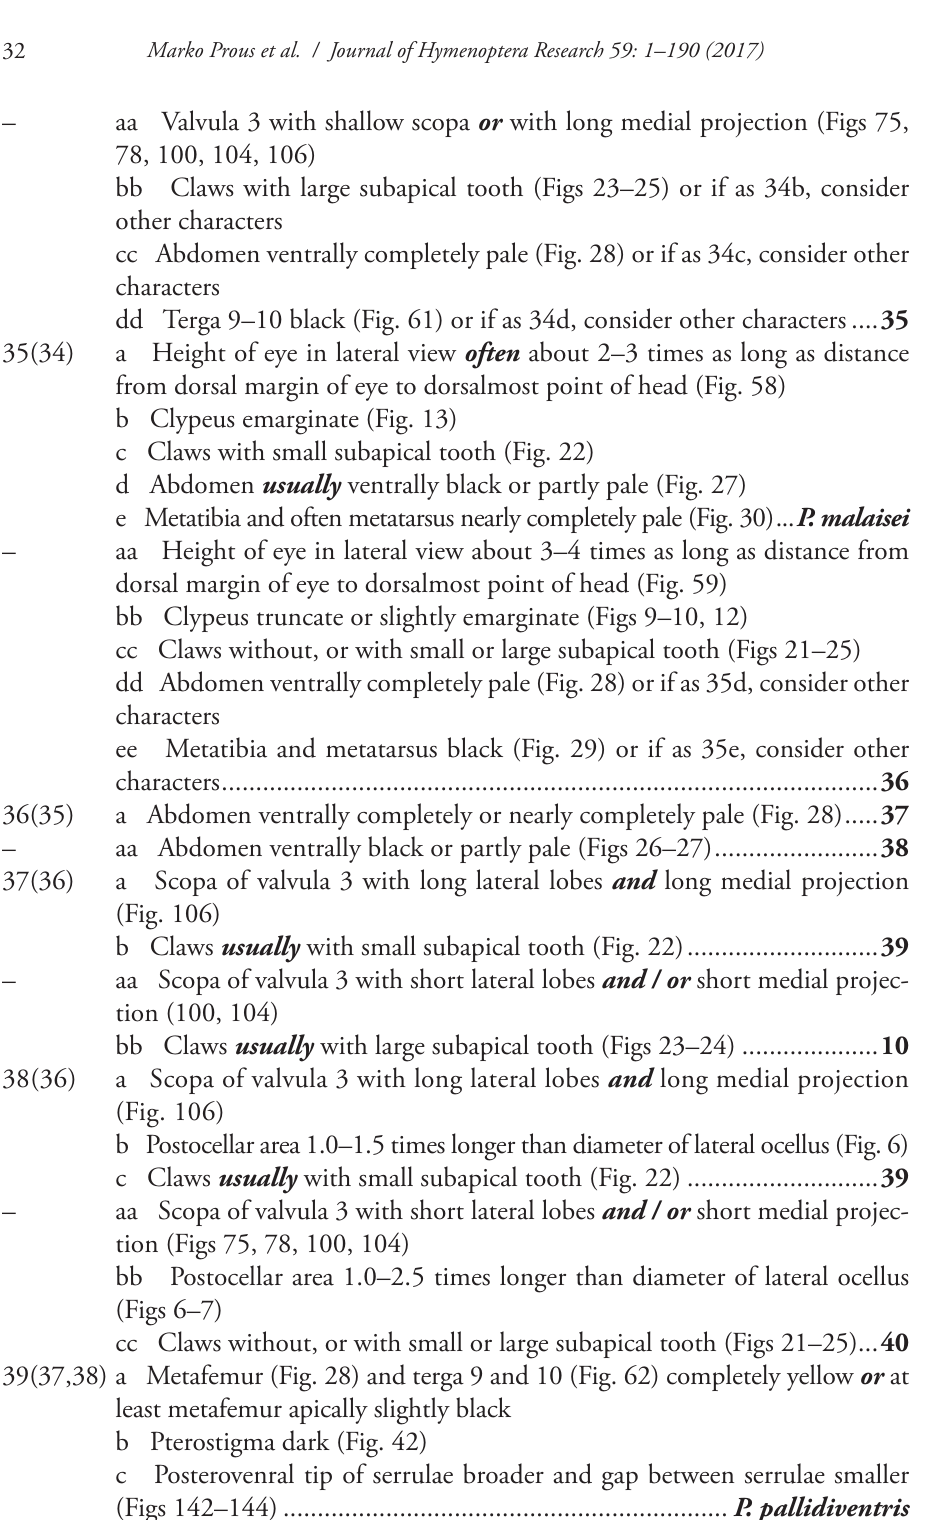
c Posterovenral tip of serrulae broader and gap between serrulae